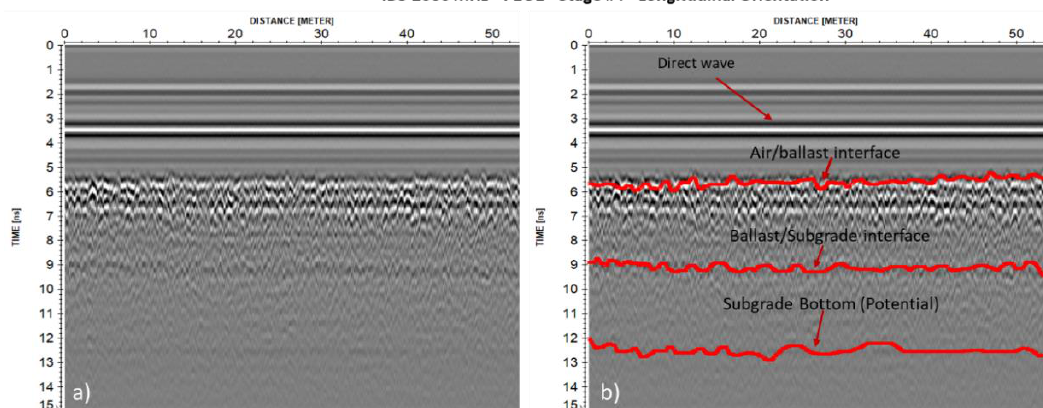
Figure 7. Preliminary interpretation of raw data from 2 GHz air-coupled antenna for section P2U1 at stage 4 with longitudinal orientation ( a ) raw data (only dewow filter is applied) ( b ) initial interface picking based on in situ visual observations and the ground truth data.